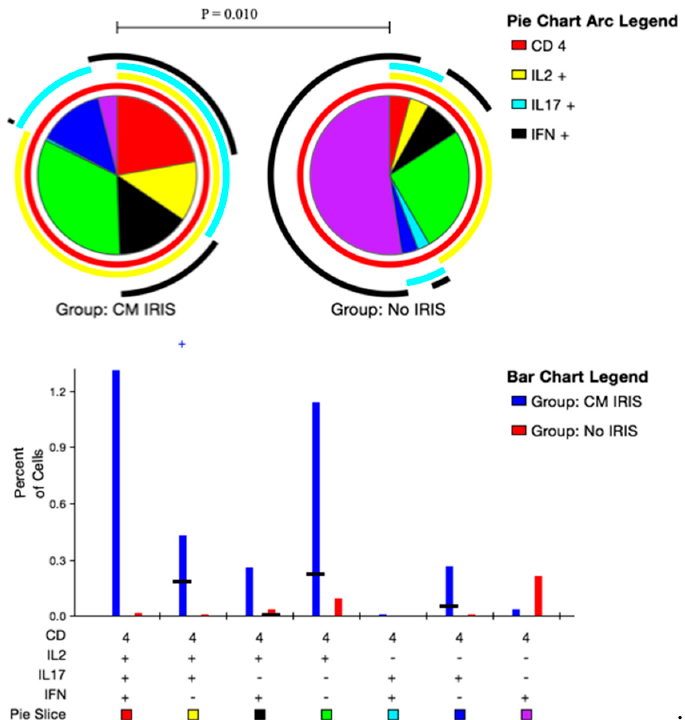
Figure 4. Peripheral blood mononuclear cells from subjects with cryptococcal meningitis were stimulated with Glucuronoxylomannan (GXM). Intracellular Interleukin-2 (IL-2), IL-17 and Interferon- γ (IFN- γ ) expression by CD4 + T cells was quantified using flow cytometry. The bar chart shows each of the three possible combination responses on the x-axis. The percentage of the total cytokine response is shown on the y-axis, with the filled bar representing the interquartile range and a black line at the median. Statistically significant di ff erences ( p < 0.05) by rank-sum testing are indicated by the plus sign. Responses from ART matched control subjects who did not develop CM-IRIS are shown in blue, responses from subjects with CM-IRIS are in red on the bar graph. The pie charts show the fractions according to the pie-slice colors shown at the bottom of the bar chart, with color-coded arcs indicating the contributions of IL-2 (yellow), IFN- γ (black), and IL-17 (cyan) to the 3-, 2- and 1-function responses. Statistical comparisons of the overall responses by permutation testing are shown in the pie category test result chart where the red represents IL-2 + IL-17 + IFN- γ + CD4 + T cells; yellow represents IL-2 + IL-17 + IFN- γ − CD4 + T cells; black represents IL-2 + IL-17 − IFN- γ + CD4 + T cells; green represents IL-2 + IL-17 − IFN- γ − CD4 + T cells; cyan represents IL-2 − IL-17 + IFN- γ + CD4 + T cells; blue represents IL-2 − IL-17 + IFN- γ − CD4 + T cells and purple represents IL-2 − IL-17 − IFN- γ + CD4 + T cells. Patients with CM-IRIS had a significantly elevated proportion of duo functional IL-2 + IL-17 + IFN- γ − CD4 + T cells compared with matched Controls following GXM